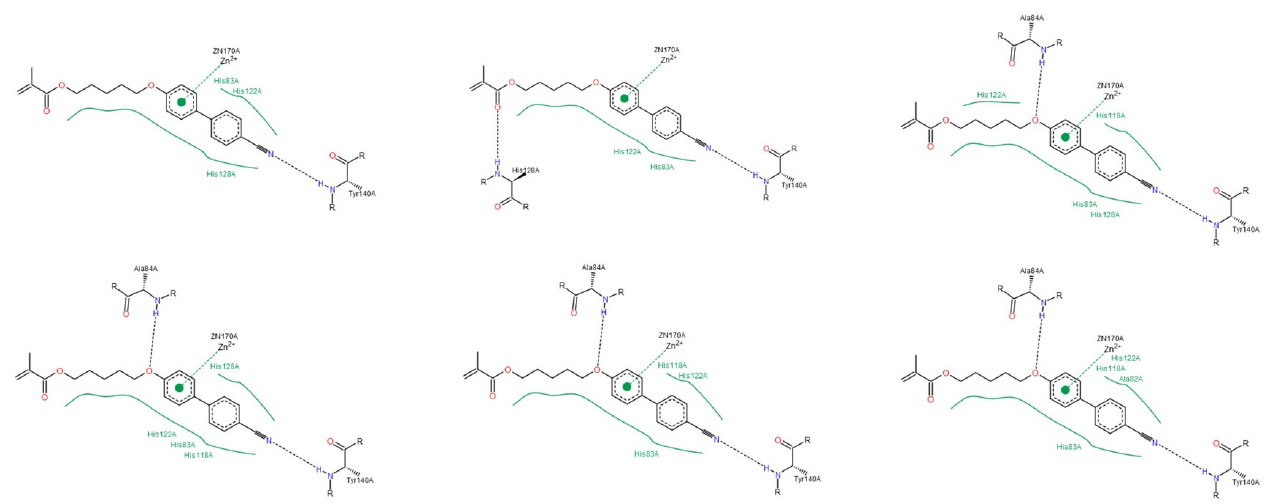
Figure A12. Interactions between compound B and MMP-2, by PoseView calculations.